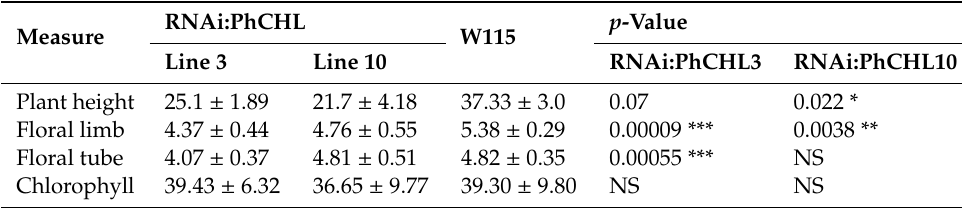
Table 1. Phenotypic analysis of RNAi:PhCHL lines 3 and 10 and comparison to non-transgenic siblings in T2 generation. Plant height, floral limb and floral tube length were measured from RNAi:PhCHL lines (3, 10) and the wild-type W115. Results, in centimeters, represent average ± standard deviation. p -value < 0.05 indicates a significant di ff erence between non-transgenic and transgenic plants, significance levels are indicated with one asterisks (* for p < 0.05), two asterisks (** for p < 0.001) and three asterisks (*** for p < 0.0001). NS indicates not significant di ff erences. Measure